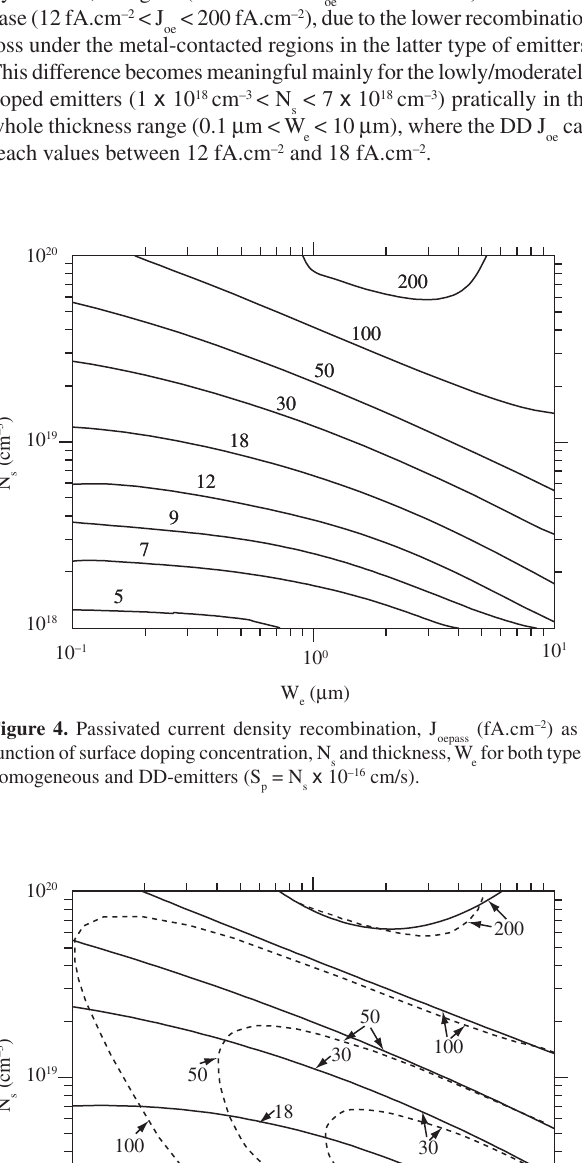
(mA/cm 2 ) as a func- sc and thickness, W of n + p structure s e